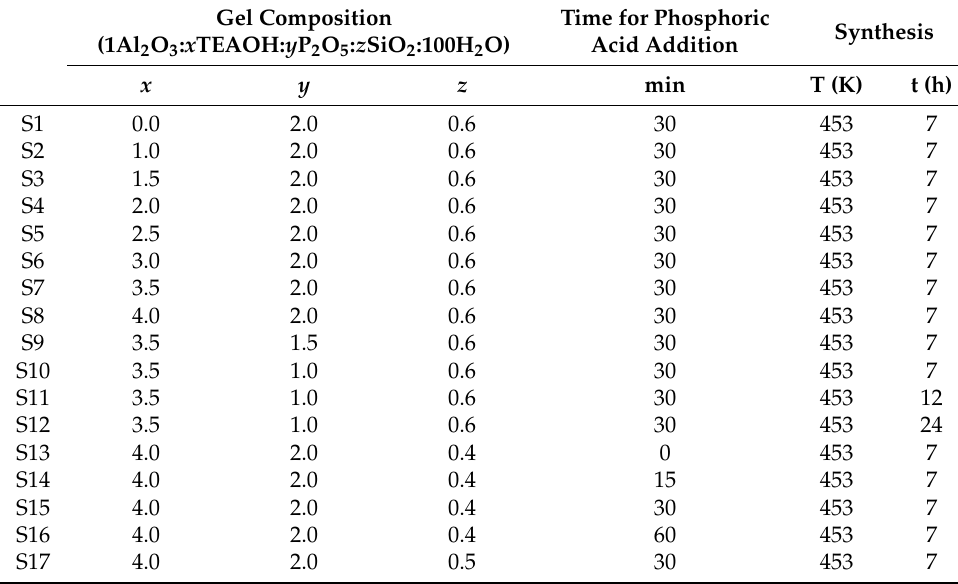
Table 1. Detailed synthesis conditions of 17 samples synthesized in the present study. Gel